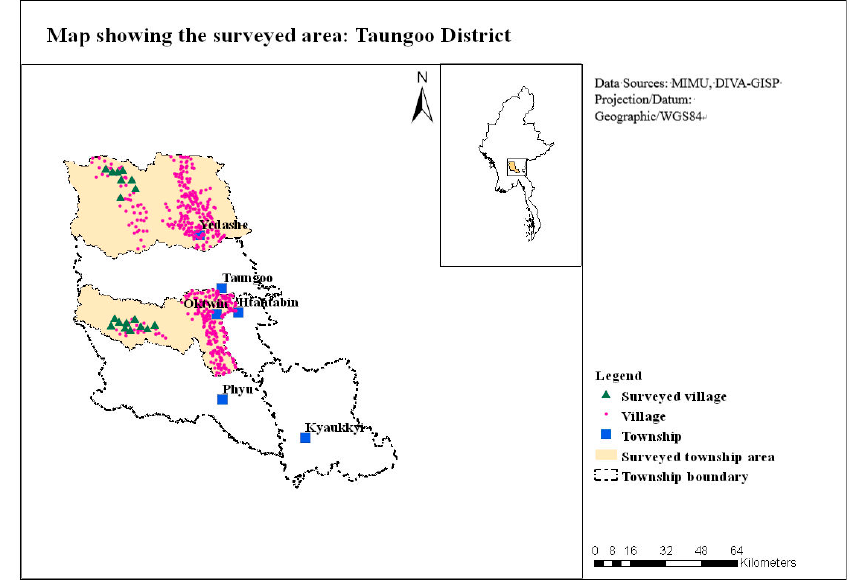
Figure 1. Study area: Taungoo District in the Bago Region, Myanmar. Note: Map created, February 2018. MIMU: Myanmar Information Management Unit; DIVA-GISP: DIVA geographic information system data portal.